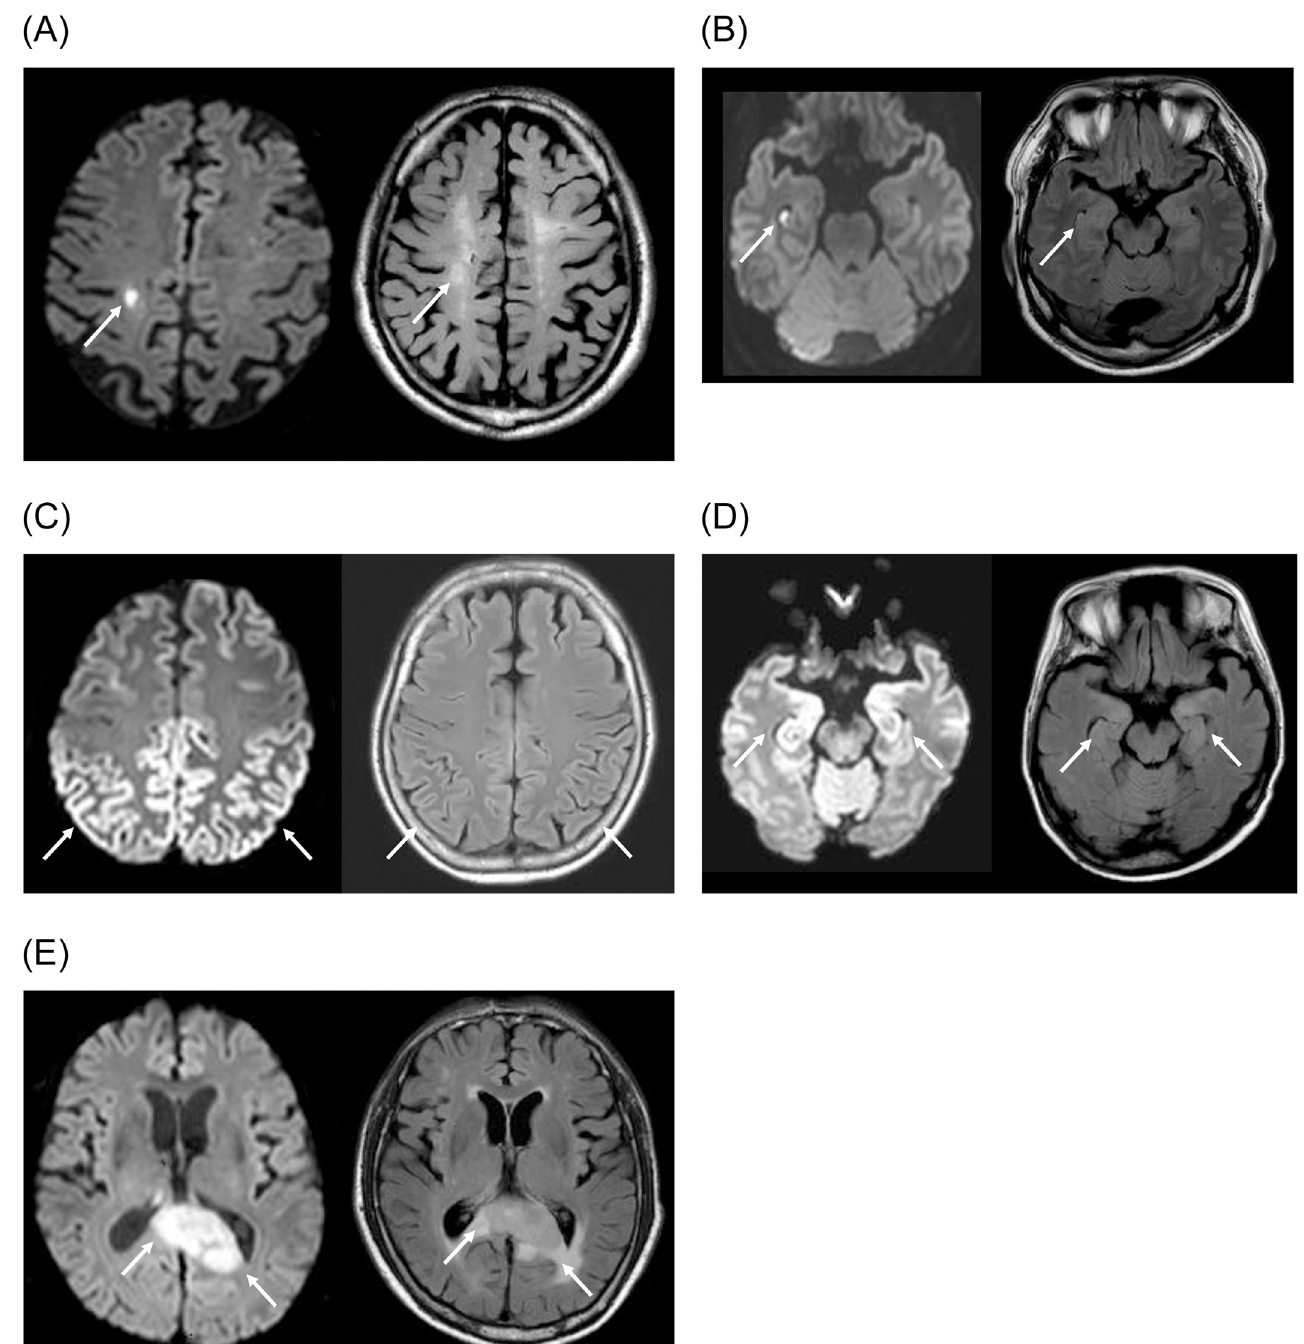
Fig 2. Exemplary diagnoses of recent small subcortical infarct, transient global amnesia, Creutzfeldt-Jakob disease, encephalitis and lymphoma made on diffusion-weighted imaging. (a) A 62 year old man with memory impairment since one year ago was subsequently diagnosed with vascular dementia. Axial diffusion-weighted image (left, b value = 1000 sec/mm2, slice thickness/gap, 2/0 mm) showed a tiny diffusion restricted lesion in the right paracentral lobule suggesting a recent small subcortical infarct (arrow). There was hyperintensity in the corresponding area (arrow) on the axial fluid-attenuated inversion recovery image (right), which was indistinguishable from white matter hyperintensity due to severe small vessel disease. (b) A 50 year old man with a history of transient memory impairment was subsequently diagnosed with transient global amnesia. Axial, diffusion-weighted image (left, b value = 1000 sec/mm2, slice thickness/ gap, 2/0 mm) showed a tiny diffusion restricted lesion in the right hippocampus (arrow). This lesion was not demonstrable in the corresponding area (arrow) on the axial fluid-attenuated inversion recovery image (right). (c) A 63 year old woman who presented with rapidly progressive memory decline was subsequently diagnosed with Creutzfeldt-Jakob disease. Axial, diffusion-weighted image (left, b value = 1000 sec/mm2, slice thickness/gap, 2/0 mm) showed diffuse cortical